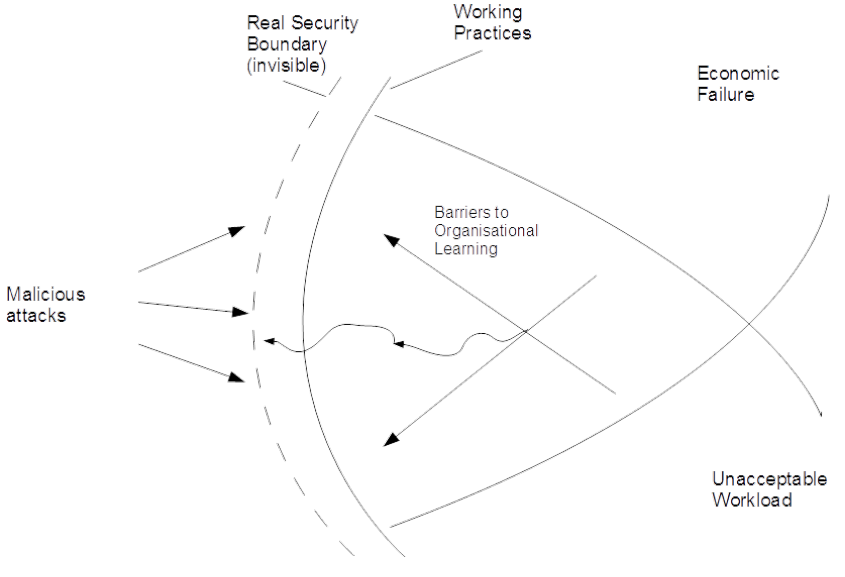
Figure 3. Breaching the Cyber Security Boundary (adapted from